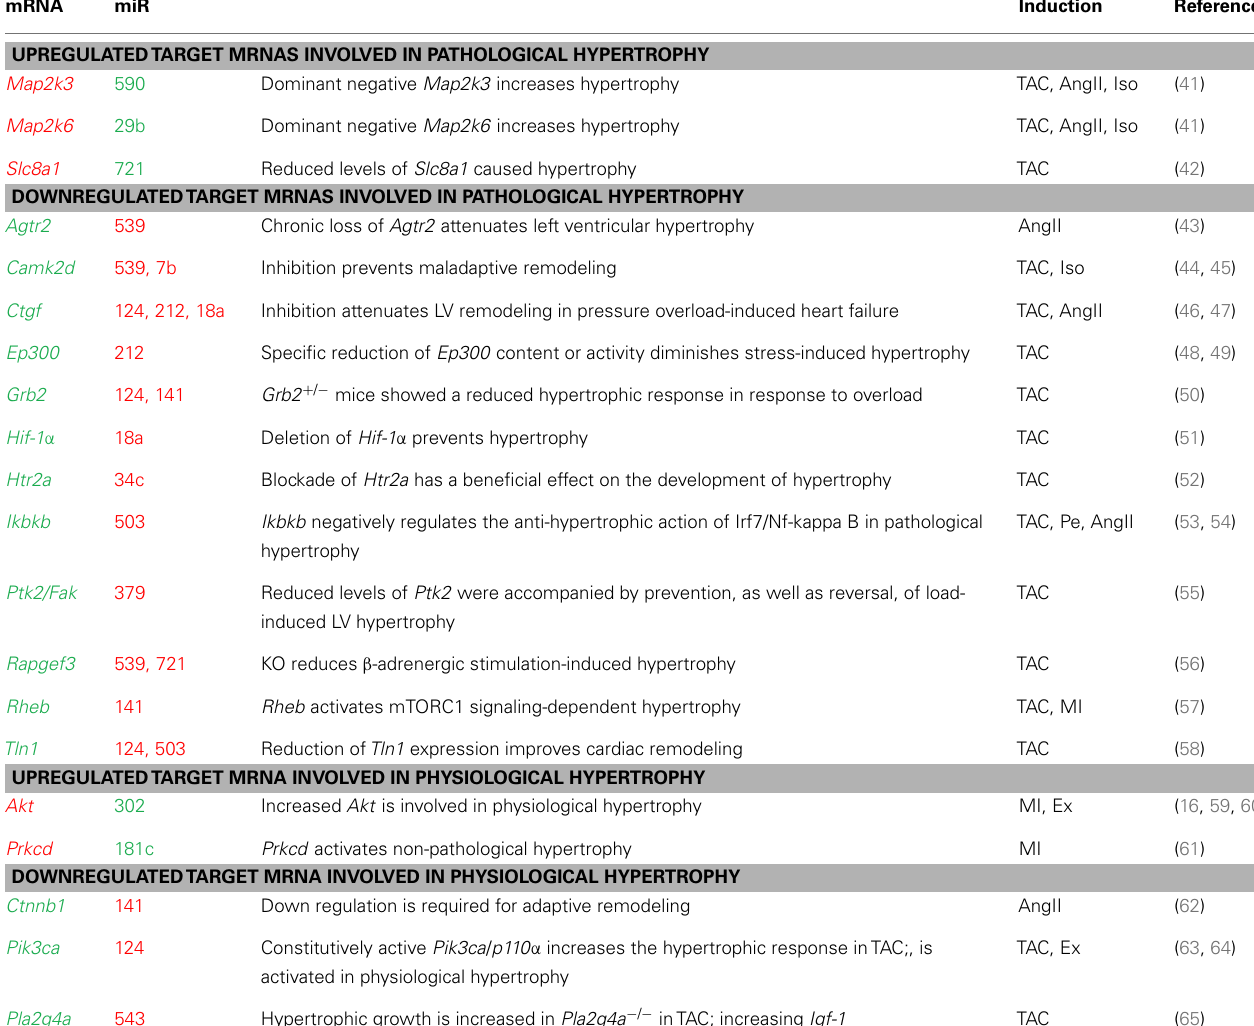
Table 2 | Predicted interaction ofT3-induced miRNA expression and hypertrophic signaling pathways